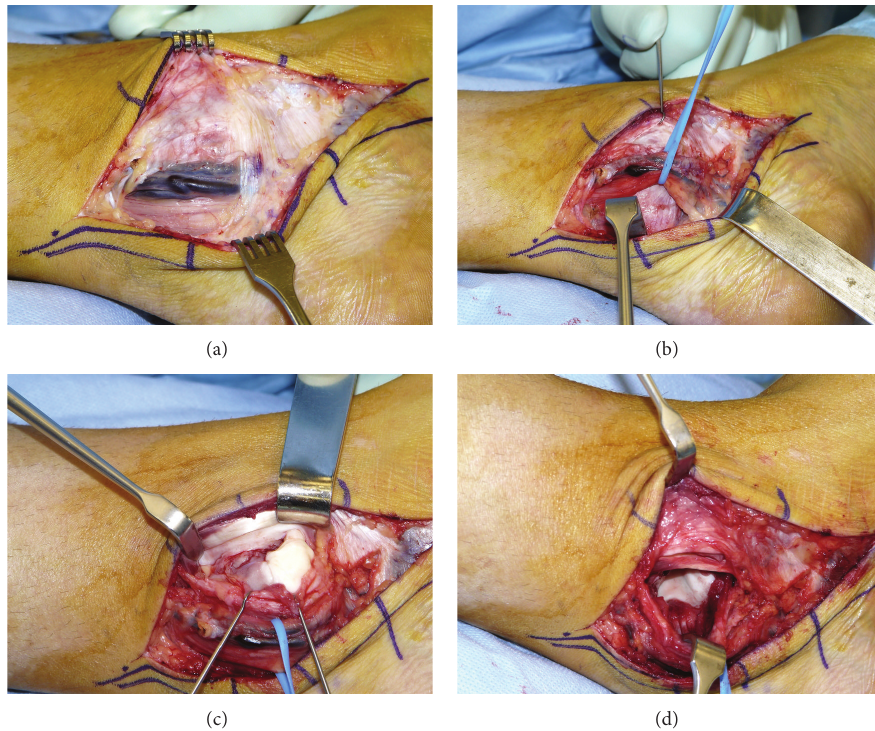
Figure 4: (a) Intraoperative aspect, neurovascular bundle (posterior tibial artery/veins, tibial nerve) and retinaculum of flexor muscles. (b) Intraoperative aspect, preparation and isolation of neurovascular bundle. (c) Intraoperative aspect, capsulotomy over the osteochondral lesion. (d) Intraoperative aspect, excision of the SOC tumor masses.